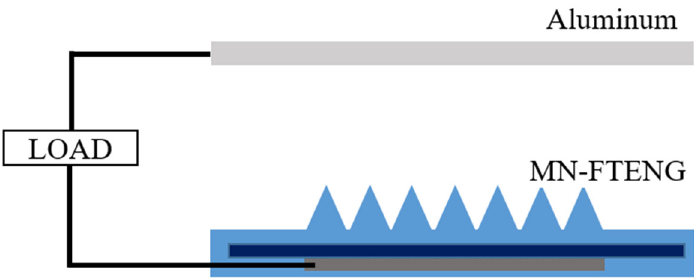
Figure 2. The electrical system of MN-FTENG. The two triboelectric layers of MN-FTENG are aluminum and MN-PDMS. Additionally, the two electrodes of MN-FTENG are aluminum and the conductive fiber inside the MN-FTENG. Since human skin has the positive triboelectric series, in the wearable device, the aluminum is replaced by human skin which becomes the other friction layer of MN-FTENG and turns the MN-FTENG into Single-electrode mode.